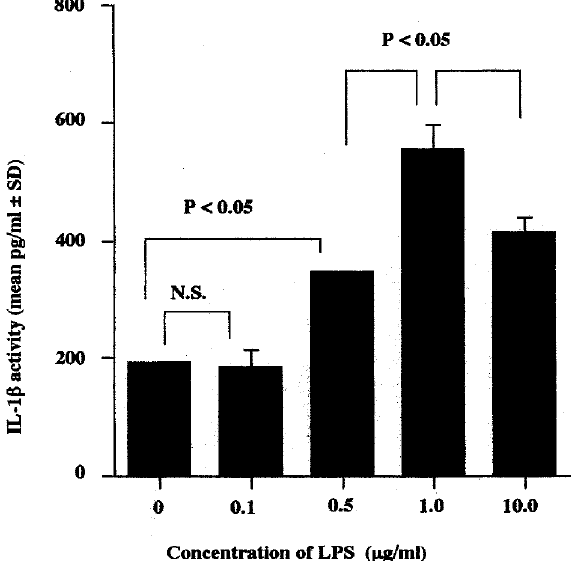
FIG. 3. Dose–response profile of the effect of LPS instillation on IL-1 b appearance in ALE. Various concentrations of LPS in a volume of 0.1ml were injected intratracheally in BALB/c mice. An ALE was prepared from mice 24h later. Each data represents the mean±SD of five individual mice of one of two different experiments with reproducible results. N.S.: not